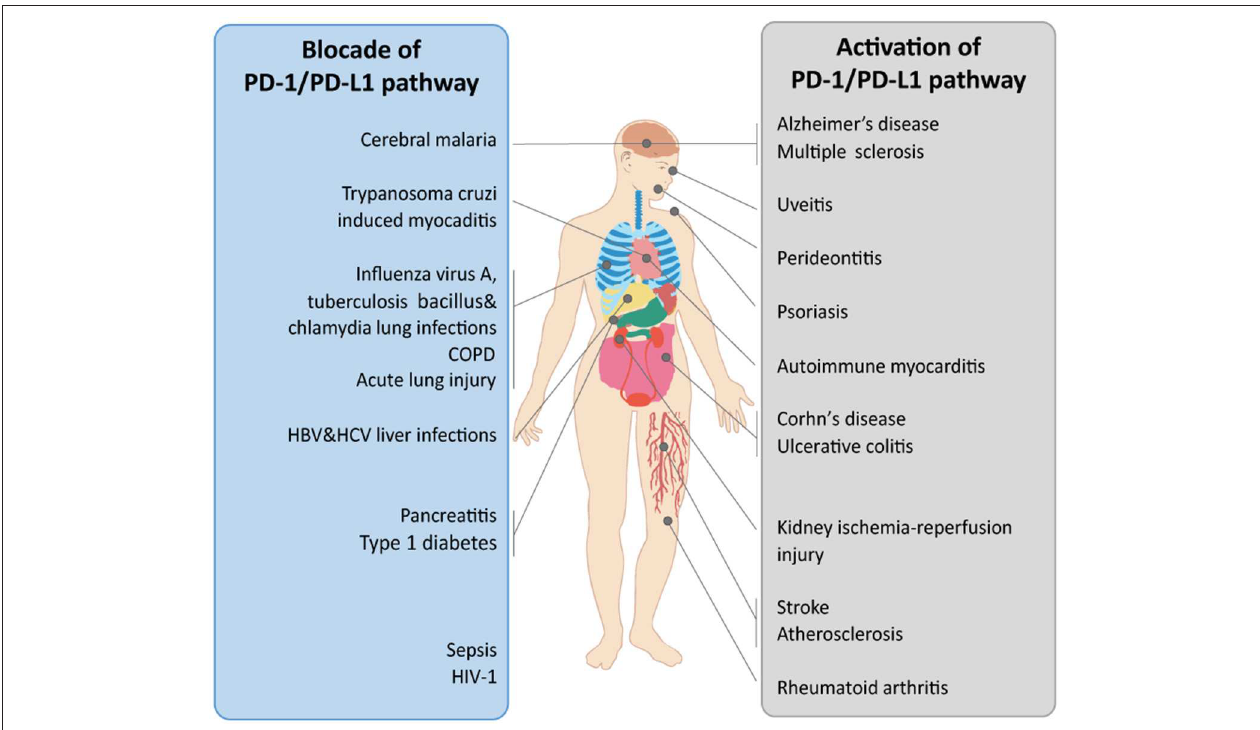
FIGURE 2 | The therapeutic potential of the PD-1/PD-L1 pathway in organ-related diseases. The PD-1/PD-L1 pathway is implicated in multiple diseases. In different diseases, the PD-1/PD-L1 pathway shows diverse functions. The therapeutic potential of the PD-1/PD-L1 pathway when treated via blockade or activation in diverse organ-related diseases is shown. COPD, chronic obstructive pulmonary disease.